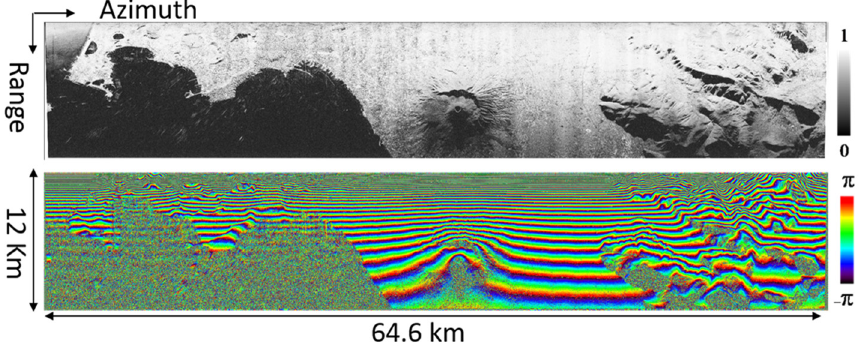
Figure 4. Coherence map and interferogram relevant to the frame 1 of Figure 3a (50 MHz mode, single-baseline configuration). The applied pixel averaging is described in the body of the paper.